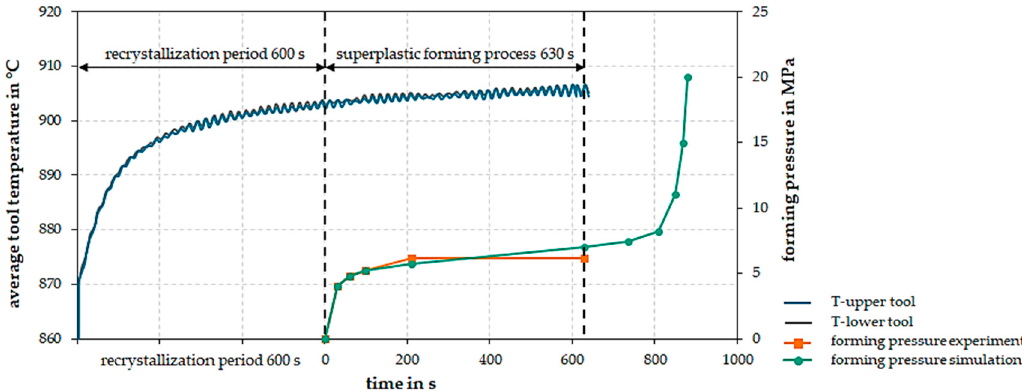
Figure 7. Comparison between the simulated pressure–time curve and actual pressure–time curve determined within the experiments.